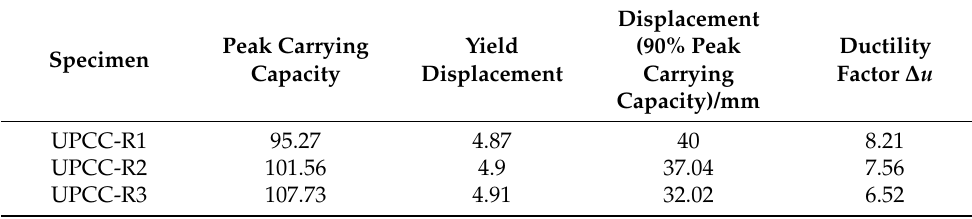
Table 8. Ductility coefficient of specimens under different initial prestress.